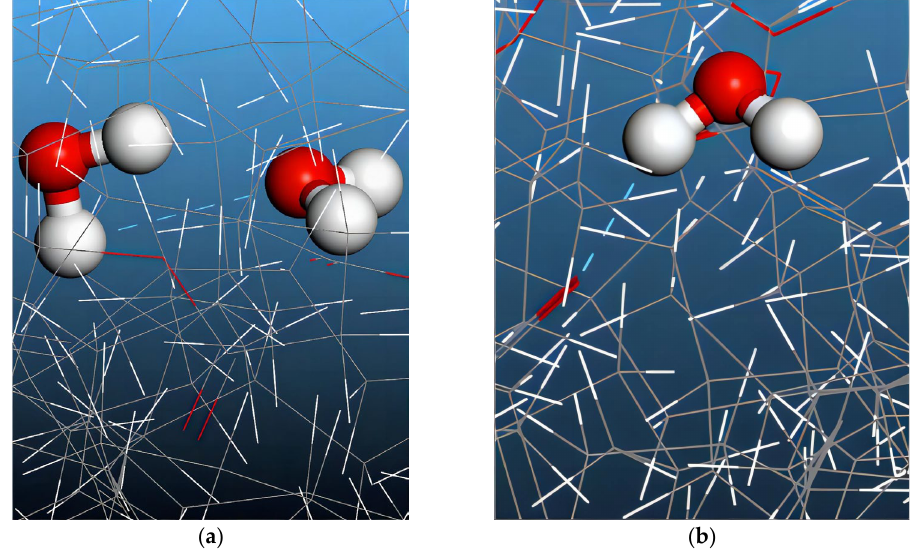
Figure 5. H-bonds formed in mixed oil model: ( a ) hydrogen bonds formed between water molecules; ( b ) hydrogen bonds formed between VO molecules and water molecules.